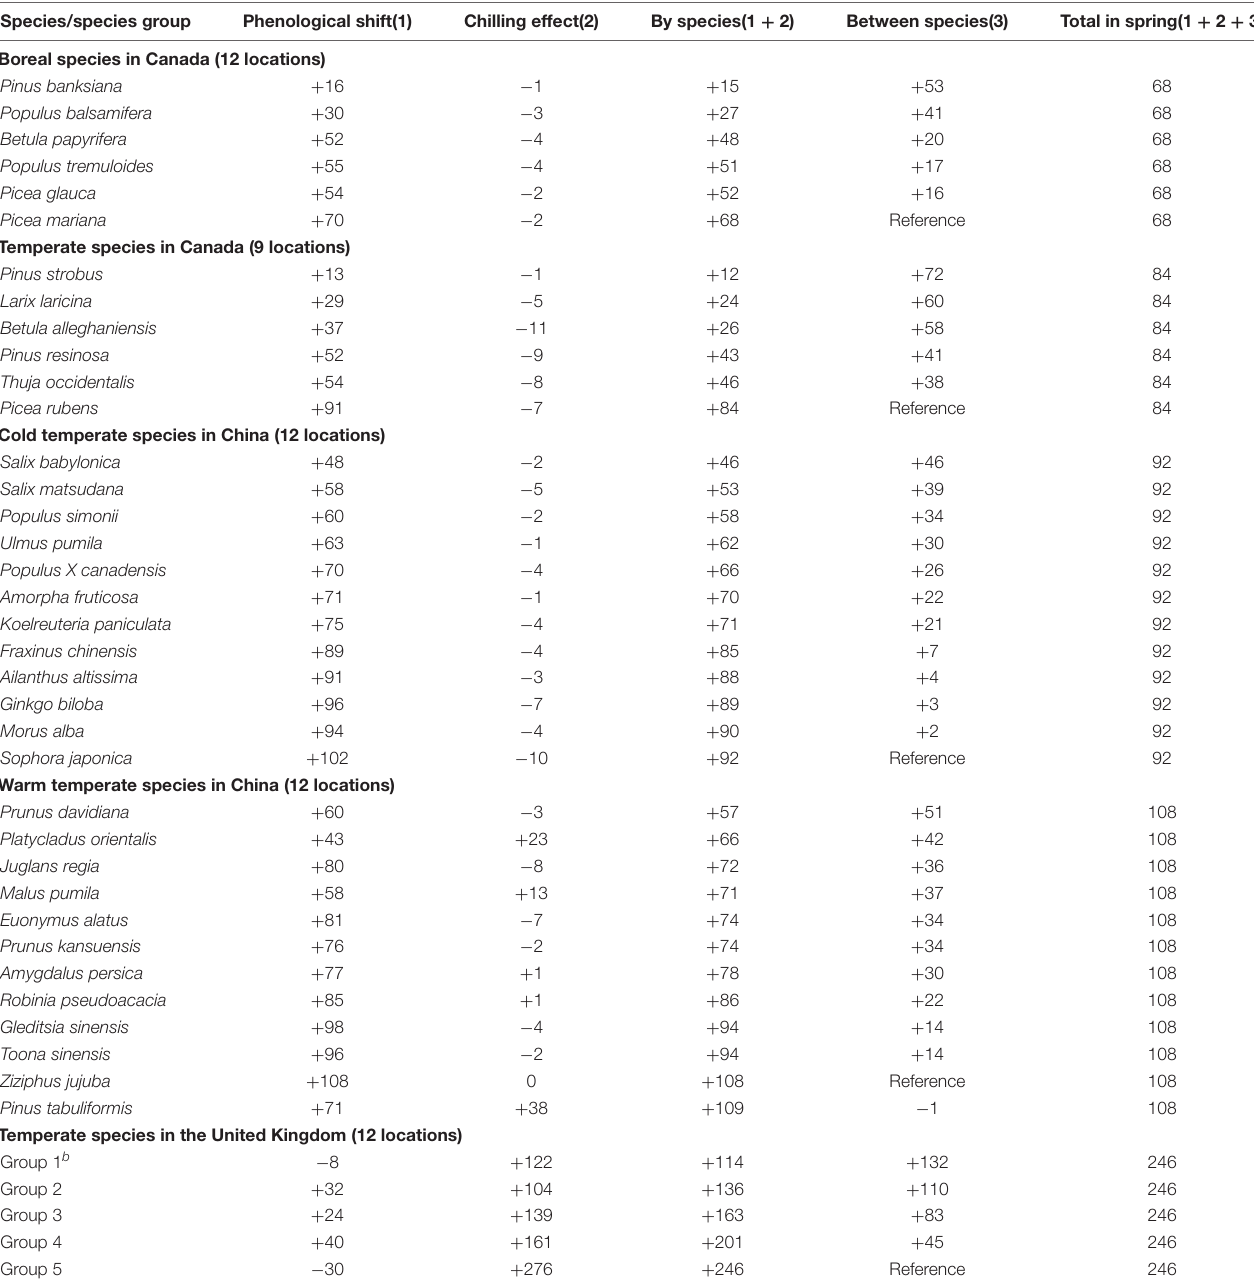
TABLE 2 | Mean forcing gains (changes in cumulative growing degree days > 5 ◦ C since January 1) from 2 ◦ C uniform increases of 1981–2010 temperatures by species/species groups and climate regions (averages over 30 years and 9–12 locations a ). Species/species group Phenological